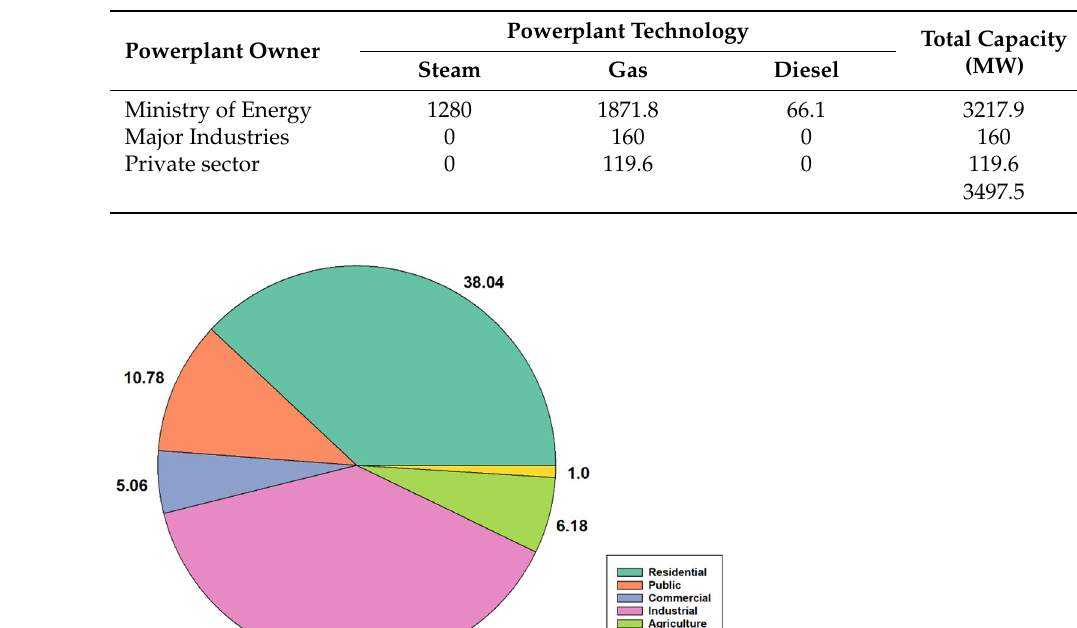
Table 1. The details of Hormozgan powerplants and their installed capacity [22].